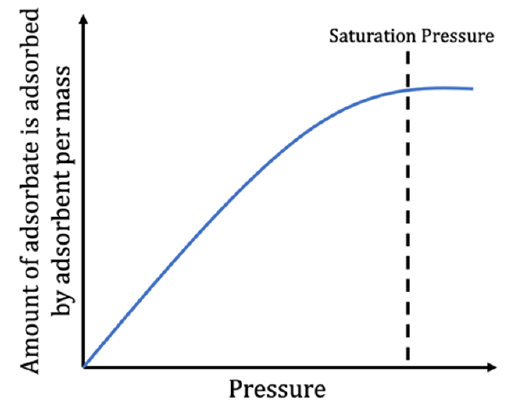
Figure 6. Graph of adsorption capacity against pressure in batch adsorption. Surface area also plays an important role in affecting the overall adsorption process. Since adsorption is categorized as a surface phenomenon, it is strongly related with the specific surface, where adsorption by smaller particles is relatively better compared to the larger particles. This can be achieved by breaking up larger particles into smaller ones that open certain small scales, hence increasing their surface area for greater adsorption [33]. Lastly, the presence of co-existing ions will also affect the uptake capacity of the adsorbent as increasing active sites will also increase the competition of the material surface within themselves. Since water typically consists of various component types, the mixture of compounds sometimes increases the mechanism of adsorption and at certain times interferes with another one. Competition between adsorbates in mixed solutions depends on the molecular size of the adsorbents, the concentration of the solutes and their relative affinity [33]. Table 7 summarizes the roles of each parameter in affecting the overall adsorption process.